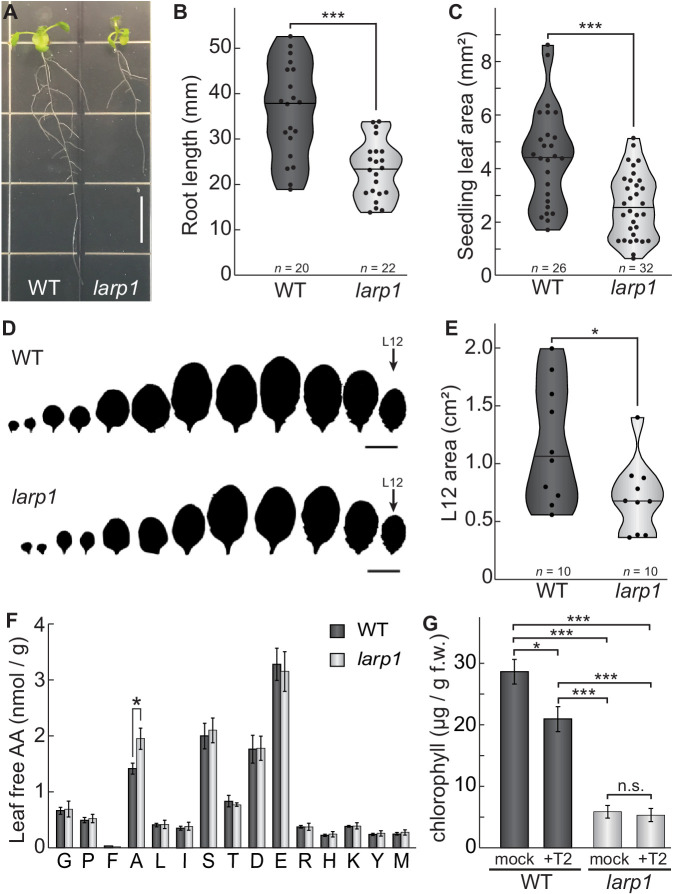
LARP1 is required for normal plant growth and physiology.(A) Arabidopsis larp1 seedlings grown for 15 days in half-strength MS agar plates were smaller than WT seedlings (white scale bar, 1 cm), with shorter roots (B) and smaller leaf area (measuring the area of the first two true leaves) (C) in larp1 than WT seedlings. Results are represented with violin plots; the line shows the median and the dots represent each measurement (***p<0.001, t test). (D) Leaf outlines of 4-week-old WT and larp1 plants (Scale bar = 1 cm) showed that recently-emerged larp1 leaves (L12) are significantly smaller than WT, as shown with violin plots in (E). Results are represented with violin plots; the line shows the median and the dots represent each measurement (*p<0.05). (F) Alanine levels were higher in larp1 leaves than in WT. Free amino acid levels are depicted in a bar graph showing average levels in WT (dark gray) and larp1 (light gray) from four samples, with error bars representing standard error (*p<0.05). (G) Total chlorophyll levels were reduced in WT seedlings (dark gray) when treated with 5.0 μm Torin2 and were significantly lower in the larp1 background (light gray) regardless of treatment (n > 4). The bar graph shows mean total chlorophyll levels and standard error (***p<0.001, **p<0.01, *p<0.05, n.s. = not significant).